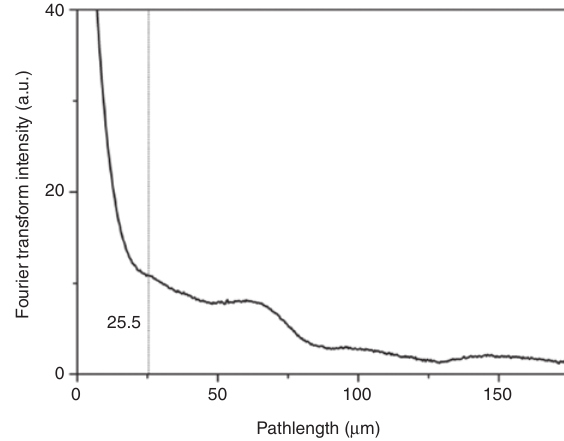
Figure 7: The Fourier transform corresponding to the emission spectrum of the LOPP of Figure 6(A) at a pump energy of 450 μ J.